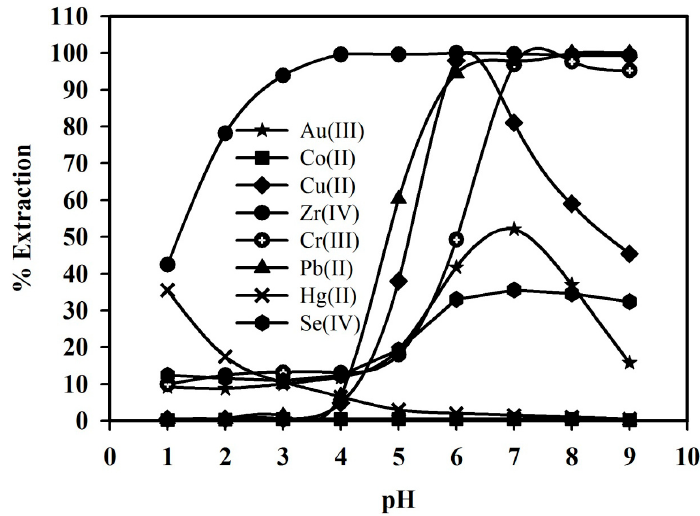
Figure 3. Effect of pH on the adsorption of 2 mg·L − 1 Zr(IV), Au(III), Cu(II), Co(II), Cr(III), Pb(II), Se(IV) and Hg(II) on 20 mg SG-APTMS-N,N-EPANTf 2 at 25 °C.